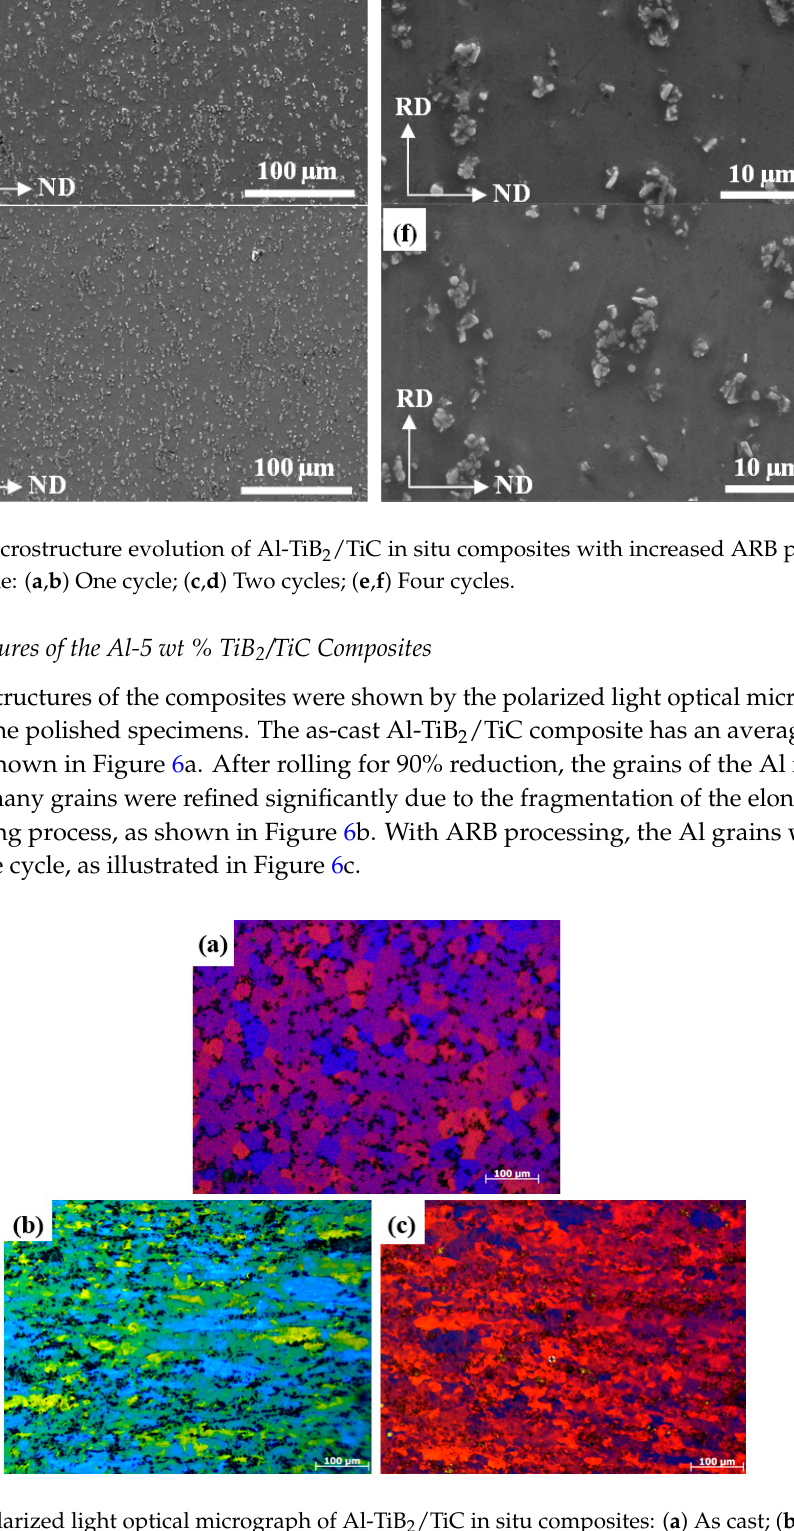
Figure 7. Typical TEM micrographs of Al-5 wt % TiB 2 /TiC composites: ( a , b ) After rolling for 90% reduction; ( c , d ) After one ARB cycle; ( e ) After two ARB cycles; ( f ) After four ARB cycles. Generally, the formation of ultrafine structures in the highly strained materials was regionally inhomogeneous because of the friction between the rolls and the strip surfaces [29]. The grain refinement mechanism during the SPD process has been explored extensively by researchers [30], who have found that fine dislocation cell structures with low-angle grain boundaries are first created